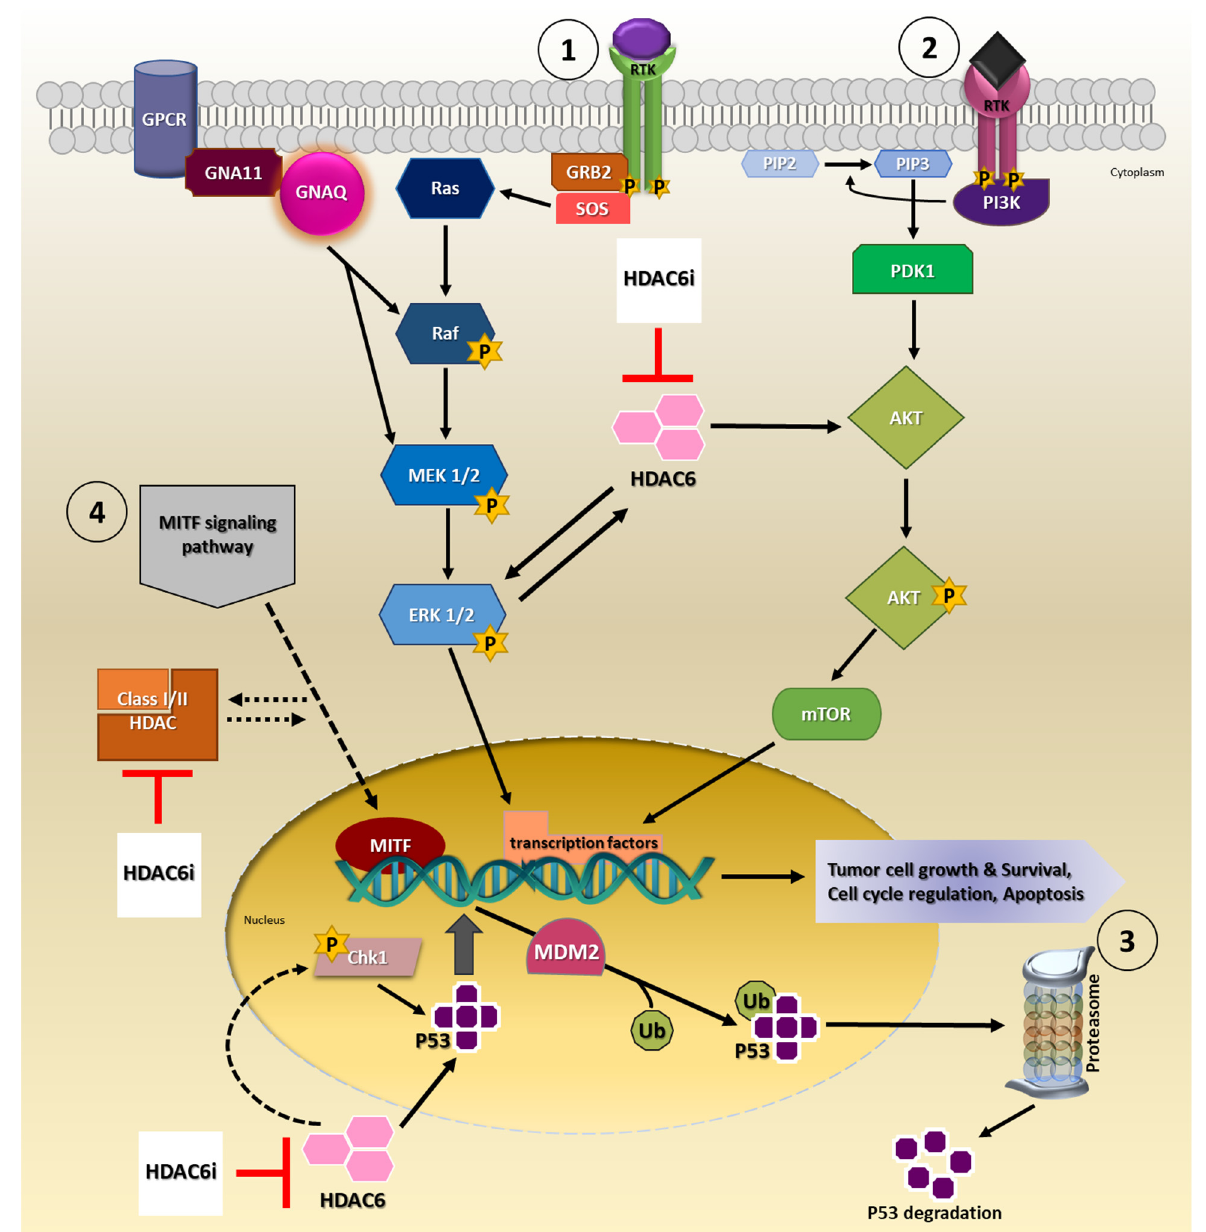
Figure 1. Involvement of HDAC6 in cancer signaling pathways. Proposed model for HDAC6i mech- anism of action by targeting either ① MAPK/ERK, ② PI3K/AKT, ③ P53 and/or ④ MITF signaling pathway(s). Consequently, targeting these pathways inhibits biological processes that promotes cell survival and proliferation in the cancer